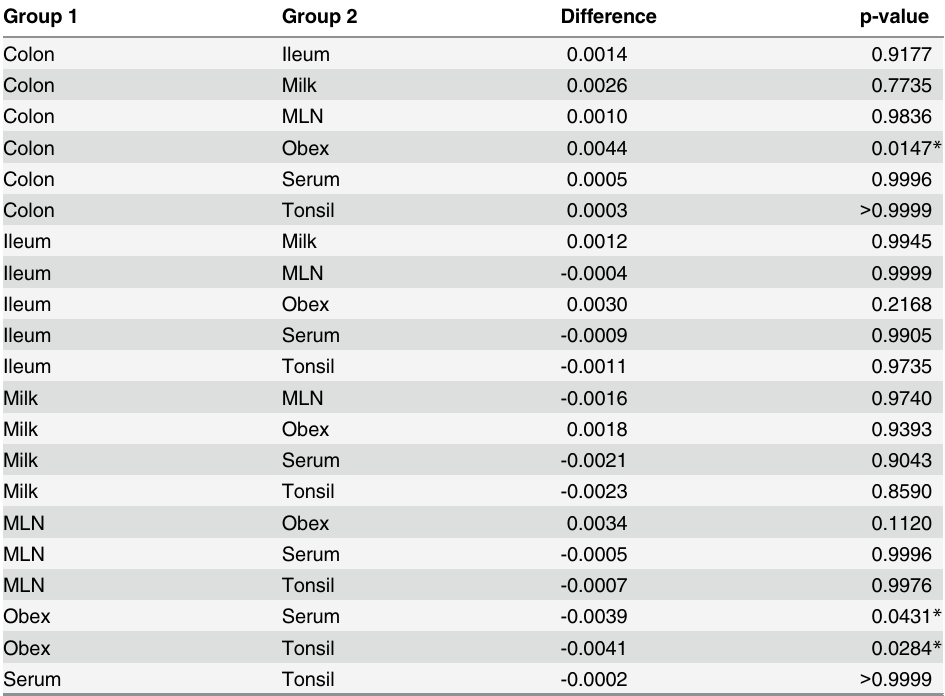
Table 2. Tukey ’ s HSD post-hoc testing for differences in diversity between different tissue compart- ments across all PI animals using the E2